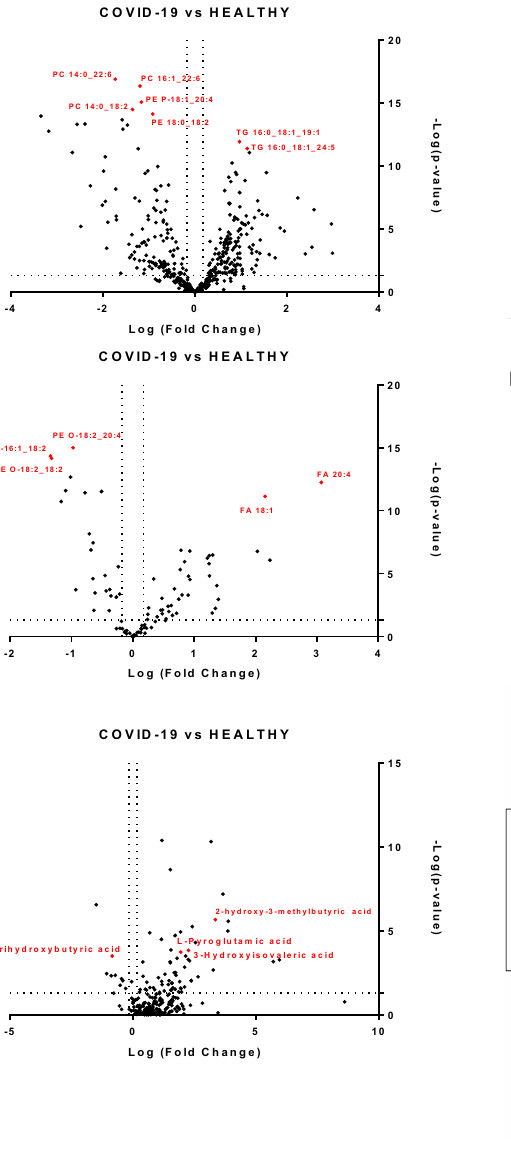
Figure 2. Modulated lipids and small molecules in SARS-CoV-2 infection. Volcano plots of quantified lipids in positive ( A ) and negative ( C ) modes. A total of 265 lipids were modulated with a p -value < 0.05 and a fold change > 1.5. Hierarchical heat maps of quantified lipids in positive ( B ) and negative ( D ) modes, highlighting the two clusters of samples, with COVID-19 patients in red and healthy subjects in green. Panels ( E , F ) report the volcano plot of the quantified small molecules and the heat map, respectively.